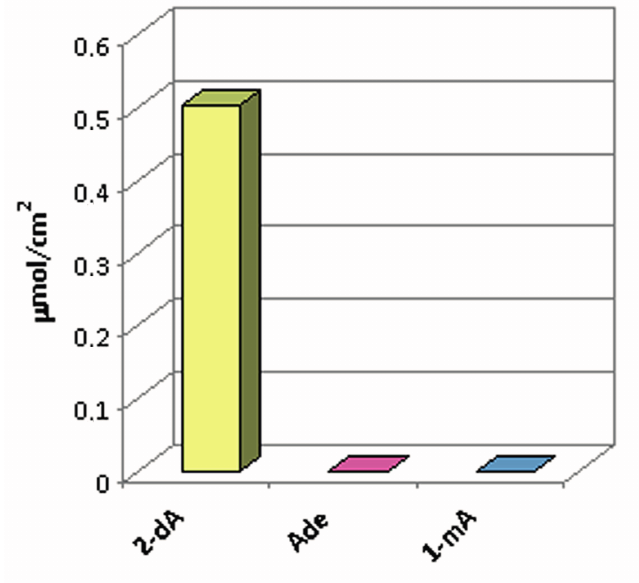
Figure 7. Selectivity studies of MIM using a mixture solution of 2-deoxyadenosine, adenosine and 1-methyladenosine at a concentration of 0.5 mmol·L − 1